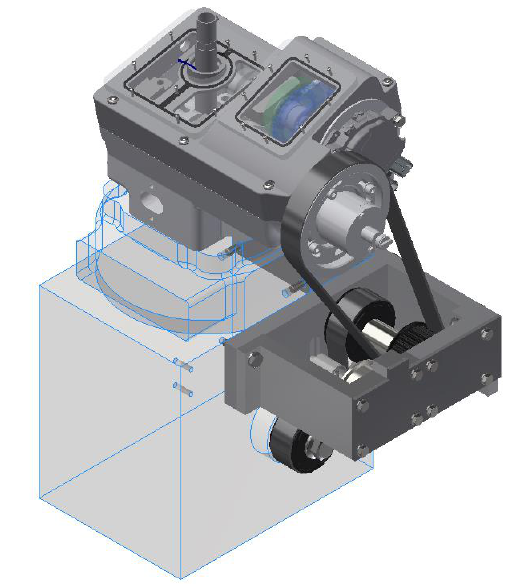
Fig. 17. The CAD model of modified cylinder head and the valve train system